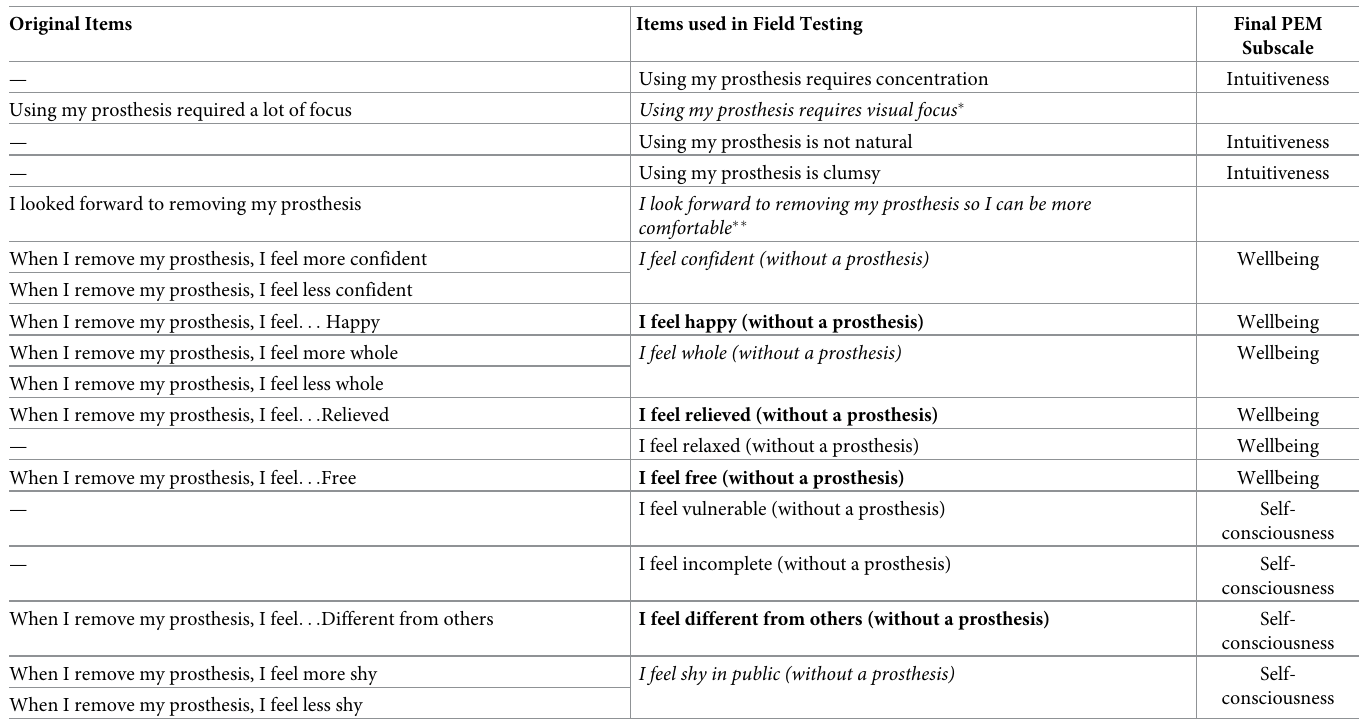
improved from 0.173 to 0.115 for the self-efficacy factor and from 0.215 to 0.083 for the intui- tiveness factor. There was no residual correlation greater than 0.2 for all other factors.